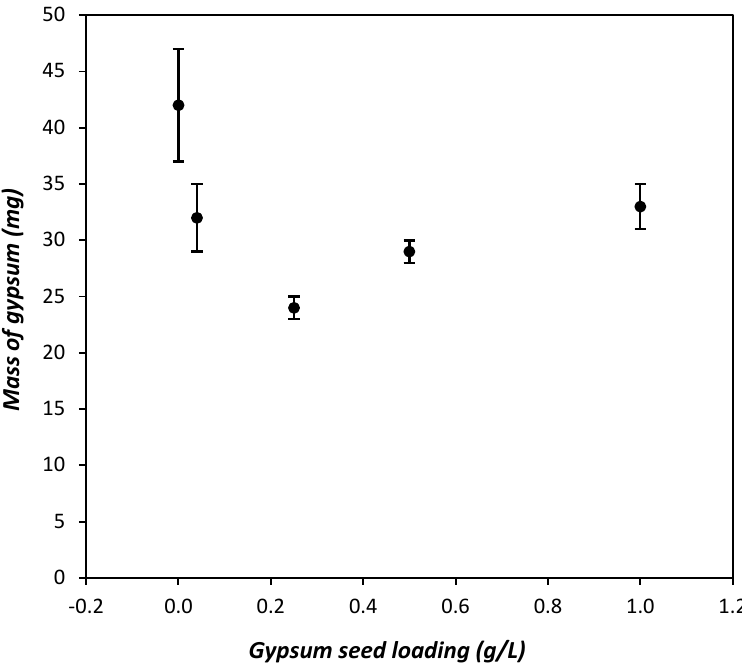
Figure 9. Seed loading against mass of gypsum scale deposited on the tube.